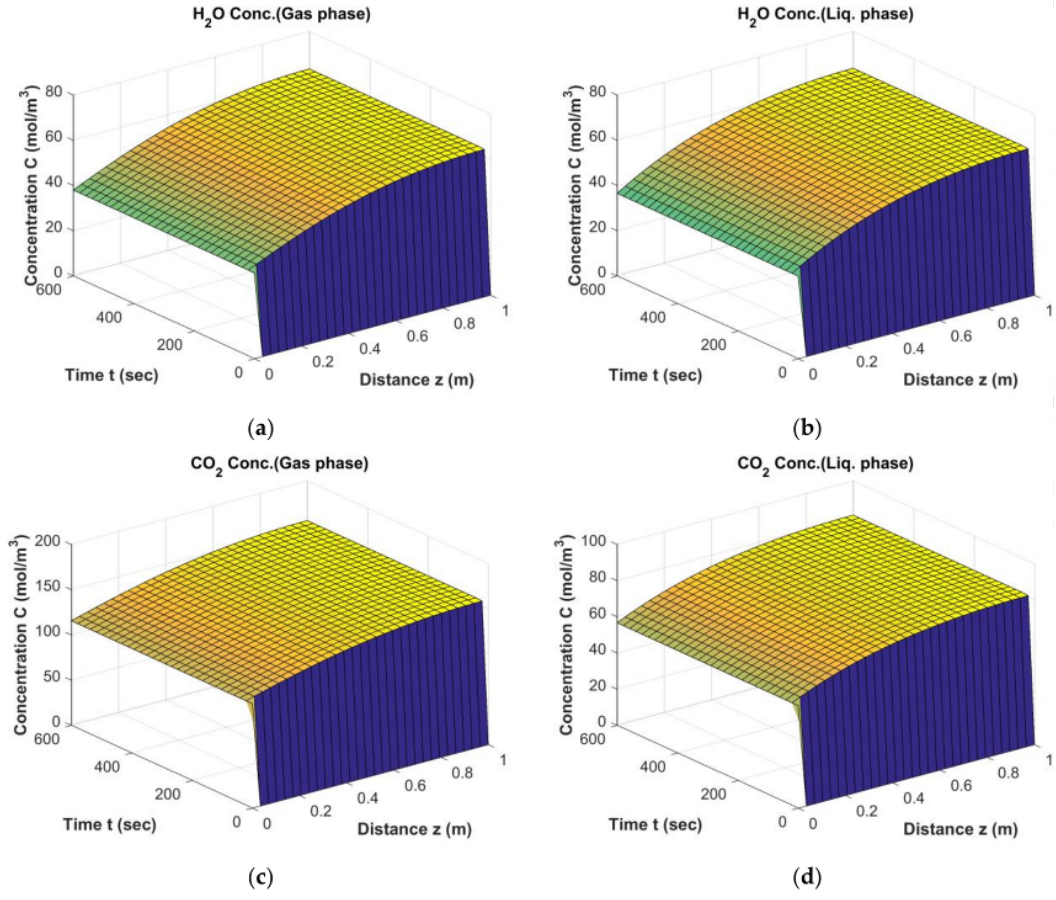
Figure 2. Results of FT Simulation; The behavior of H 2 O and CO 2 in gas phase ( a , c ) and liquid phase ( b , d ) from start-up to steady state conditions (D t = 0.1 m, H = 2.5 m, ε cat = 0.34, U g,in = 0.17